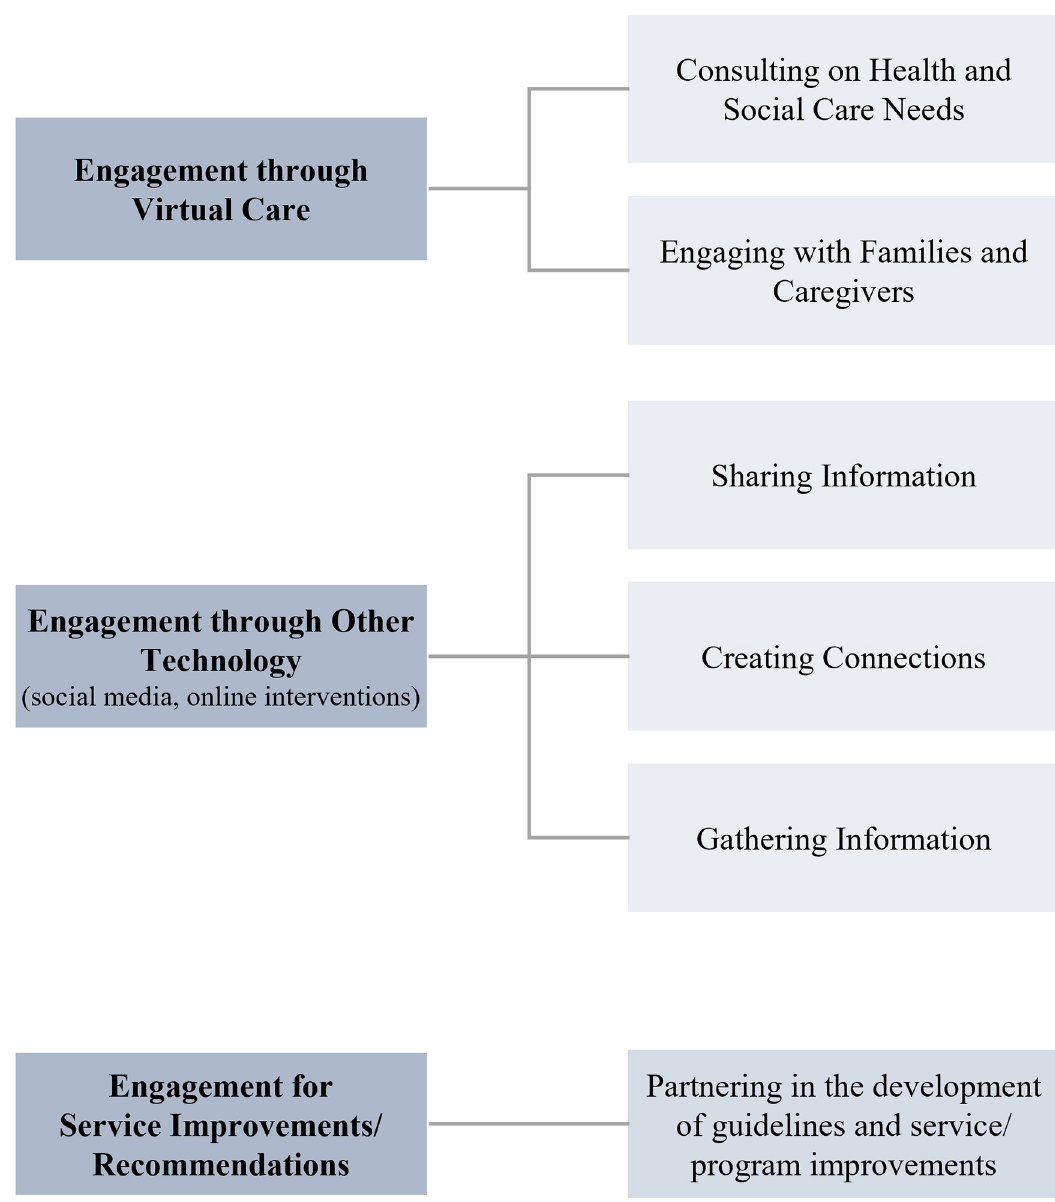
Fig 2. Methods used by health systems to stay connected with patients and families during the COVID-19